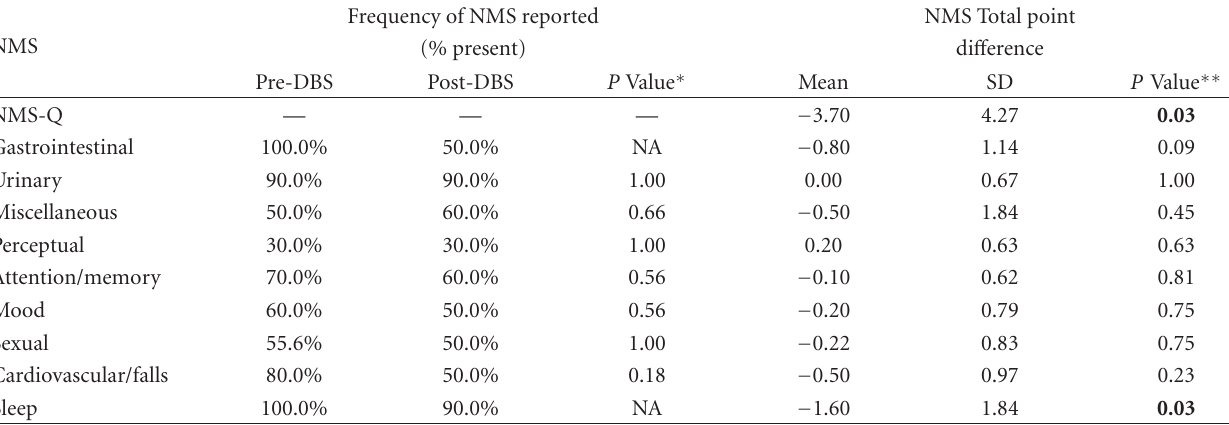
Table 1: Changes in nonmotor symptom (NMS) score from questionnaire. The left-sided group shows percent of subjects who had a positive answer in at least one of the questions in the corresponding subset. The right-sided group shows changes in NMS score as represented by the di ff erence in total score. Improvements of NMS scores prepost-deep brain stimulation surgery were significant. Also, sleep improved prepost-DBS ( P = 0 . 03).